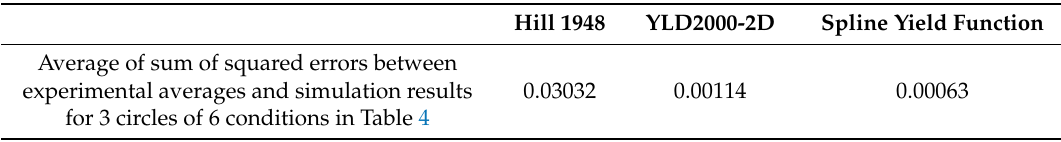
Table 6. Comparison of sum of squared errors among the yield